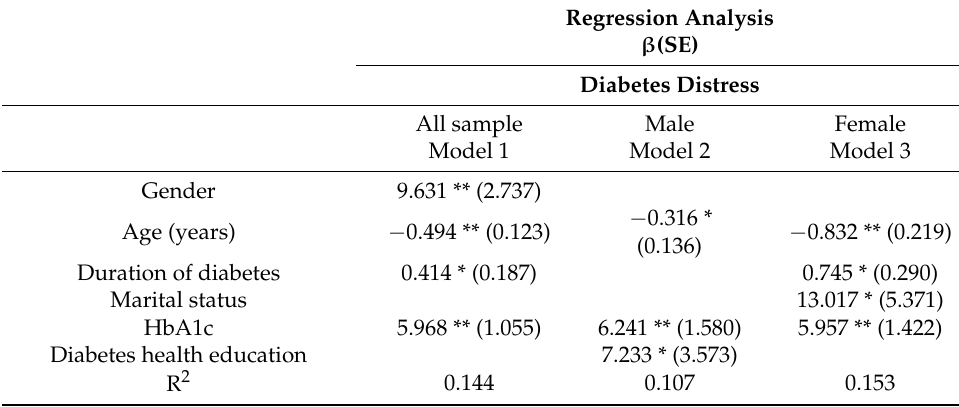
Table 2. Regression analysis of diabetes distress (total point).